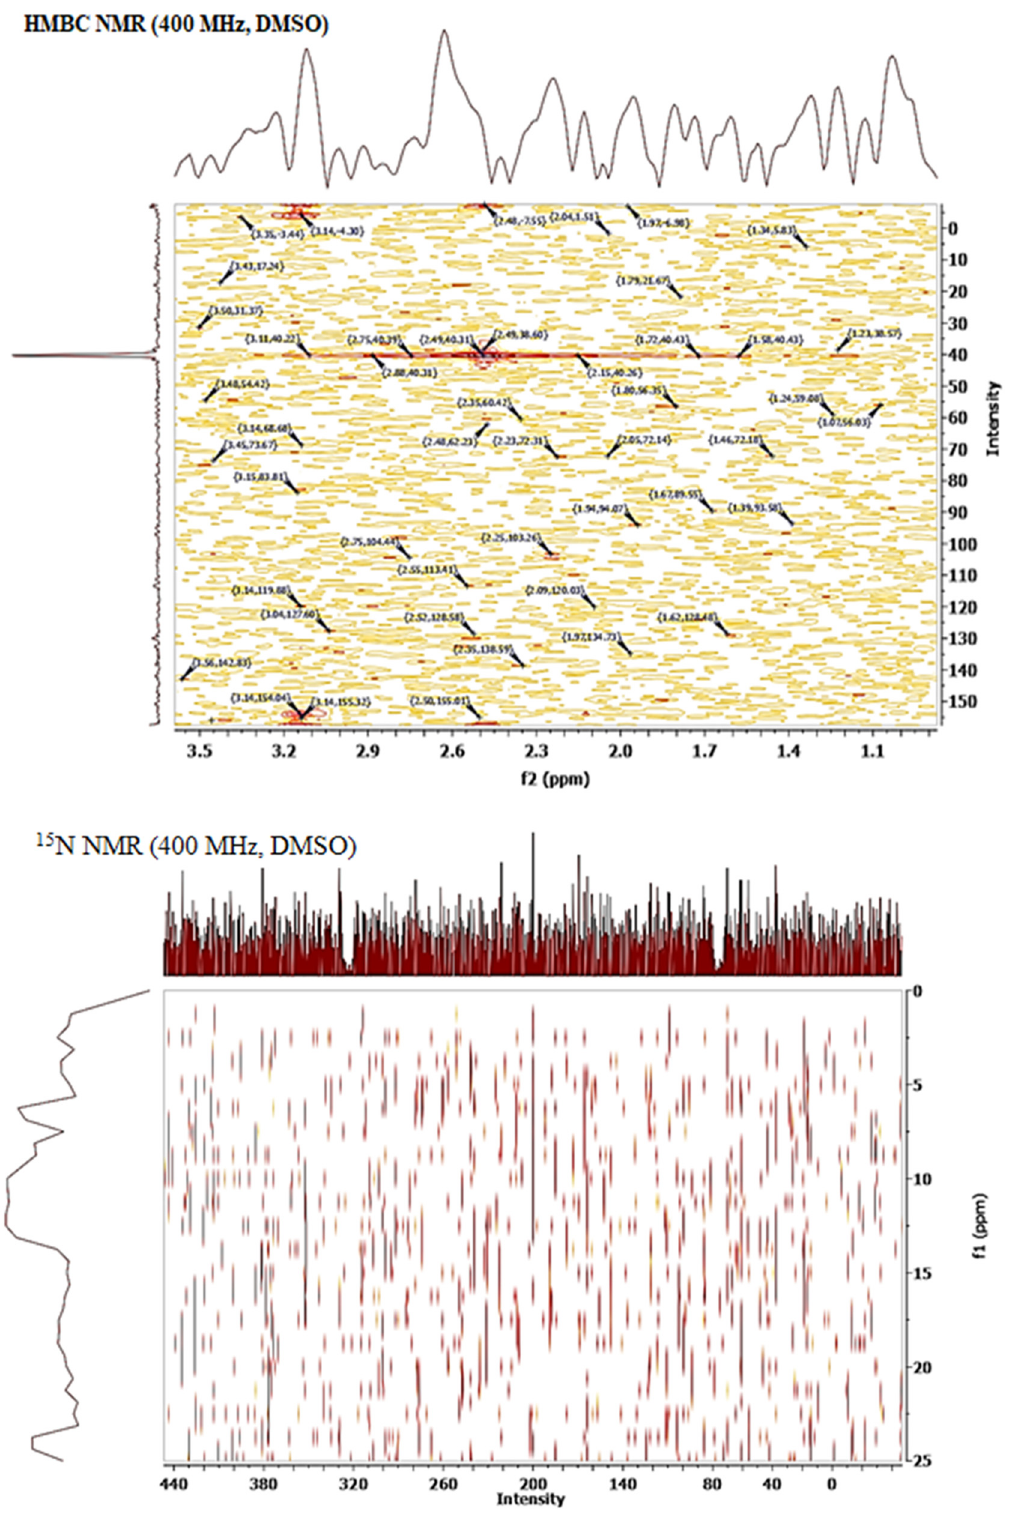
Figure 4: 1D and 2D NMR spectrum of pumpkin pectin extracted from peel ( a ) 1 H NMR, ( b ) 13 C NMR, ( c ) HMBC NMR, and ( d ) 15 N